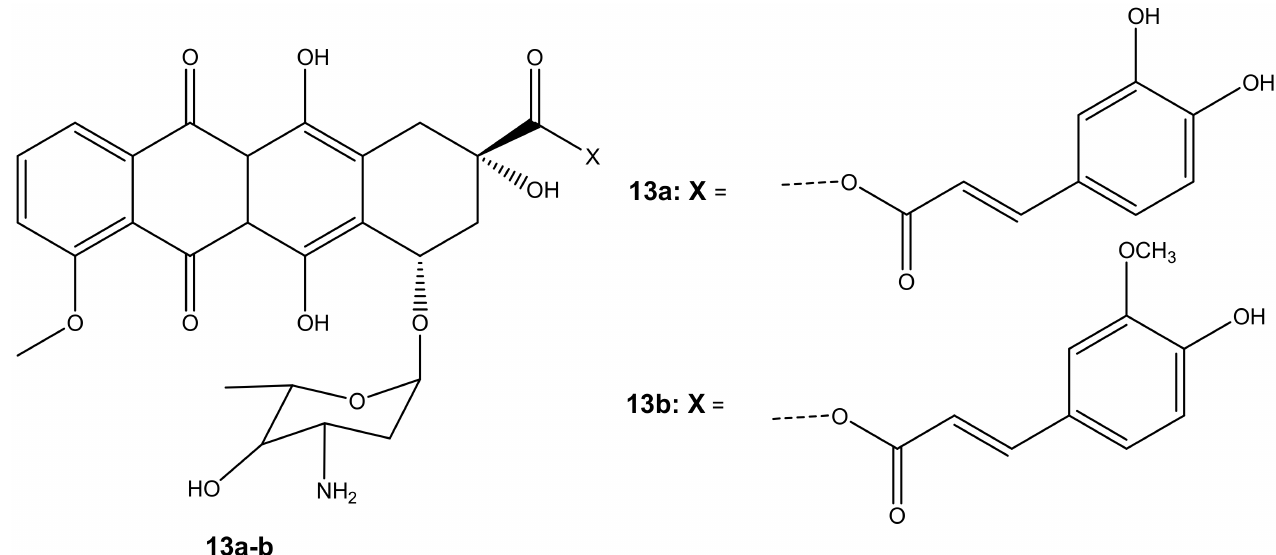
Figure 9. Chemical structures of doxorubicin-antioxidant derivatives synthesized via esterification ( 13a-b